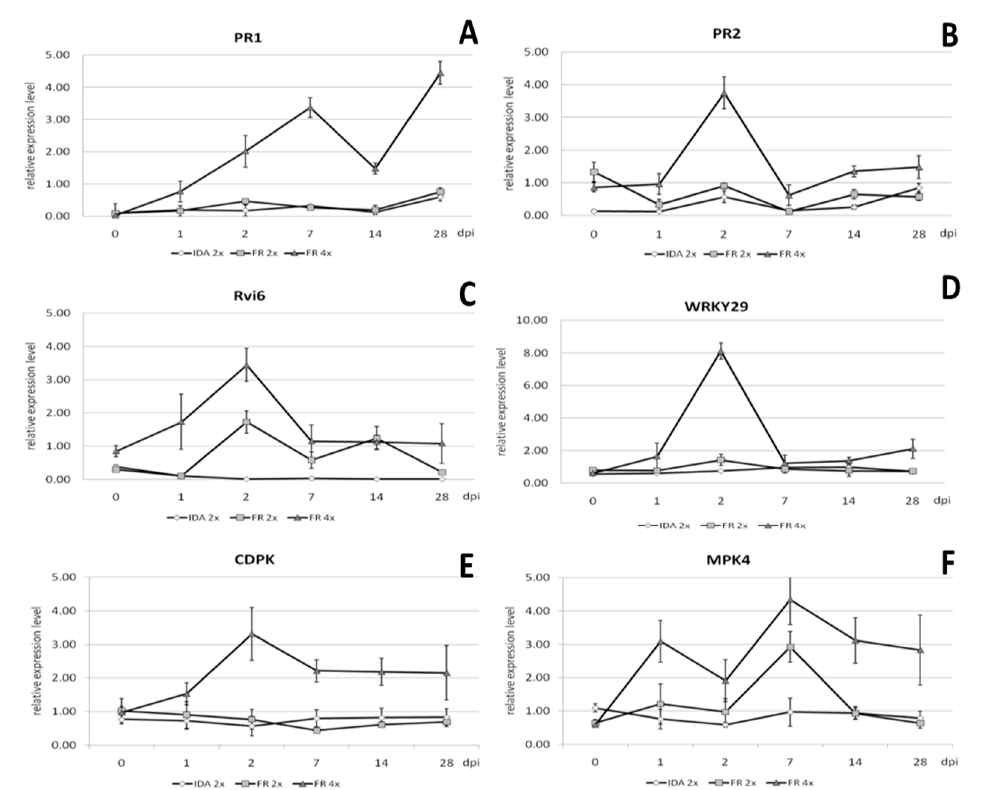
Figure 9. Relative gene expression analysis using real-time PCR of the genes ( A ) PR1 , ( B ) PR2 , ( C ) Rvi6 , ( D ) WRKY29 , ( E ) CDPK , and ( F ) MPK4 genes in the tetraploid clones of the ‘apple ‘Free Redstar’ apple during V. inaequalis infection in relation to the diploid counterpart and ‘Idared’ reference susceptible to apple scab, analysed before (0) and 1, 2, 7, 14, and 28 days post inoculation (dpi). Error bars represent standard deviation.